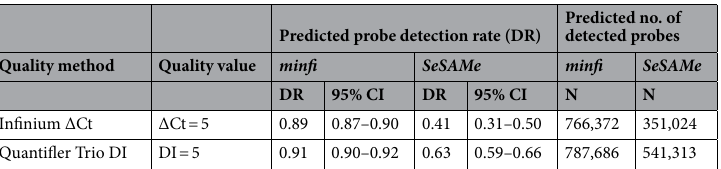
Table 2. Predicted probe detection rates and numbers of detected probes with Infinium QC ΔCt = 5 and QuantifilerTrio DI = 5 (samples of moderate quality).